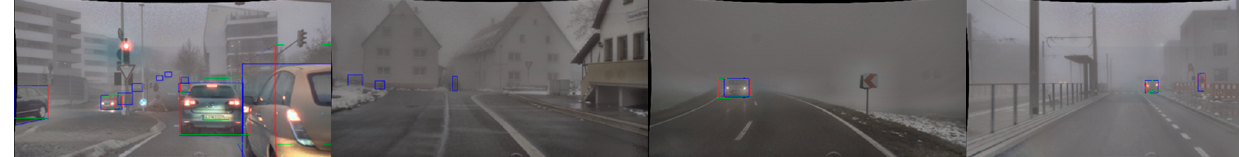
( f ) Figure 15. Dehazing result of various algorithms: ( a ) hazy image; ( b ) ground truth; ( c ) Fattal’s method; ( d ) He’s method; ( e ) Tan’s method; ( f ) proposed method. Table 4. Comparison result 1 using upper image from Figure 15. PSNR (dB)